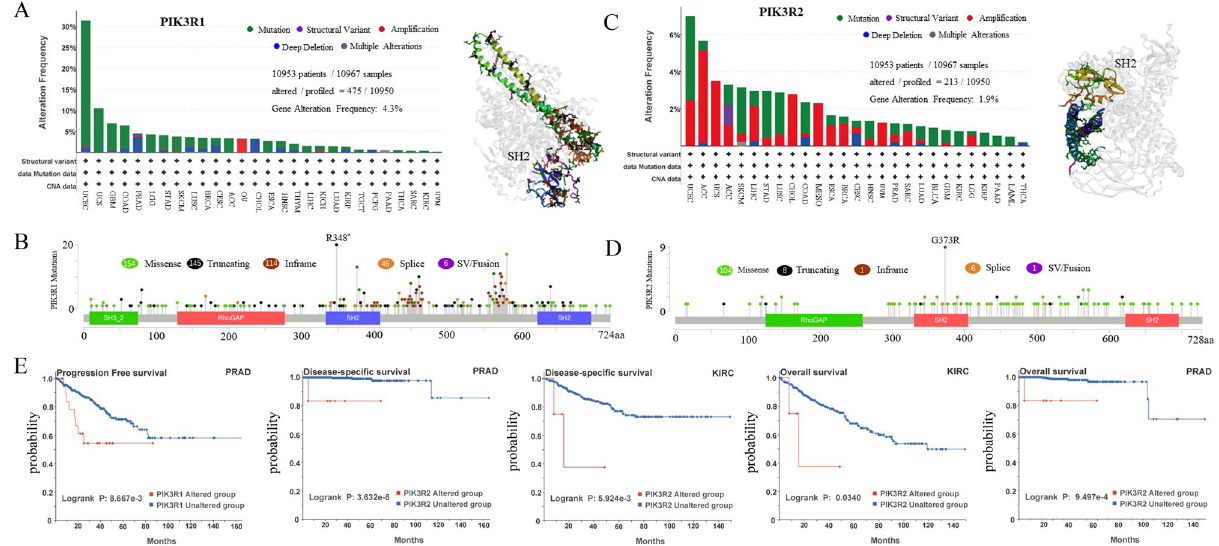
Figure 3. Mutation characteristics of PIK3R1 and PIK3R2 in different tumors of TCGA. The mutation characteristics of genes were explored via the cBioPortal database (https:// www. cbiop ortal. org/). ( A ) The alteration frequency with mutation types in all TCGA tumors and the 3D structure of PIK3R1. ( B ) Sites of different mutation types of PIK3R1. ( C ) The alteration frequency with mutation types in all TCGA tumors and the 3D structure of PIK3R2. ( D ) The sites of different mutation types of PIK3R2. ( E ) Relationship between the mutation status of genes and patient